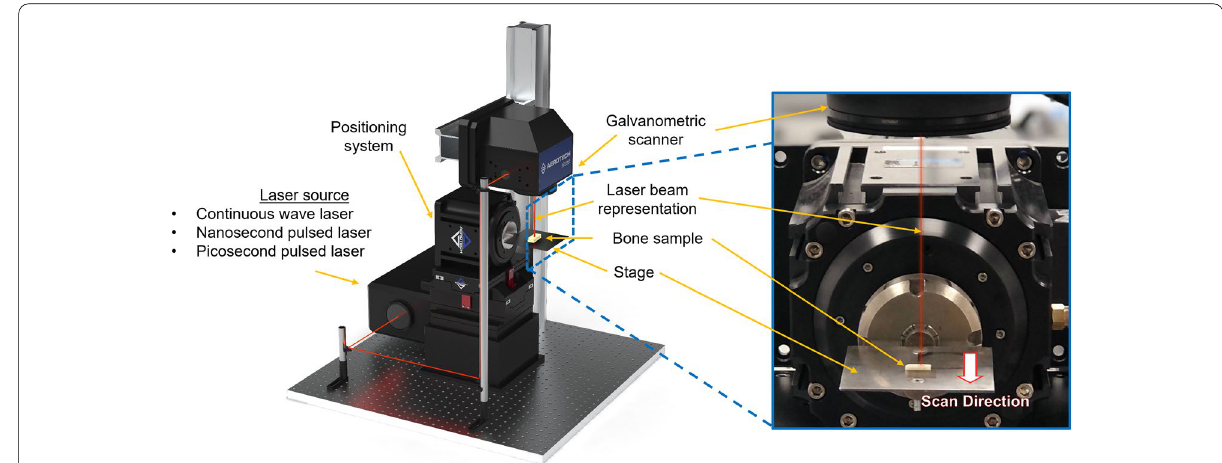
Figure 2 Diagrammatic overview of the experimental setup for laser machining single trenches in bone: the experimental setup uses three different lasers (represented as a single laser source for clarity) and a galvanometric scanner in conjunction with a multi‑axis positioning system to control the feed speeds for machining single trenches in the bone